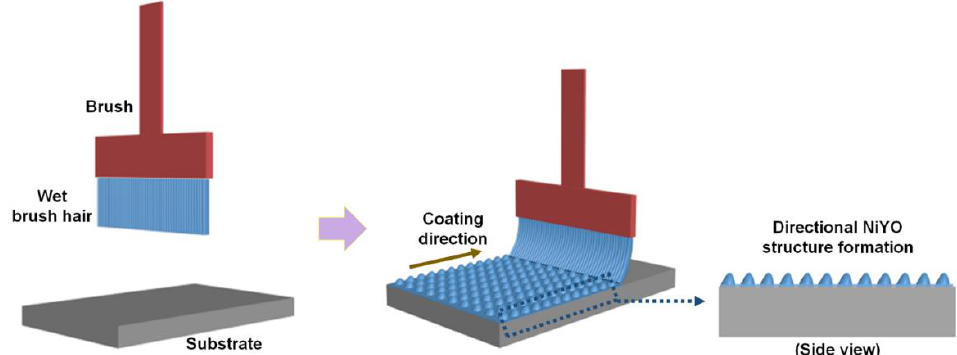
Figure 1. Brush coating process illustration and the expected structure of nickel yttrium oxide film after the curing process.